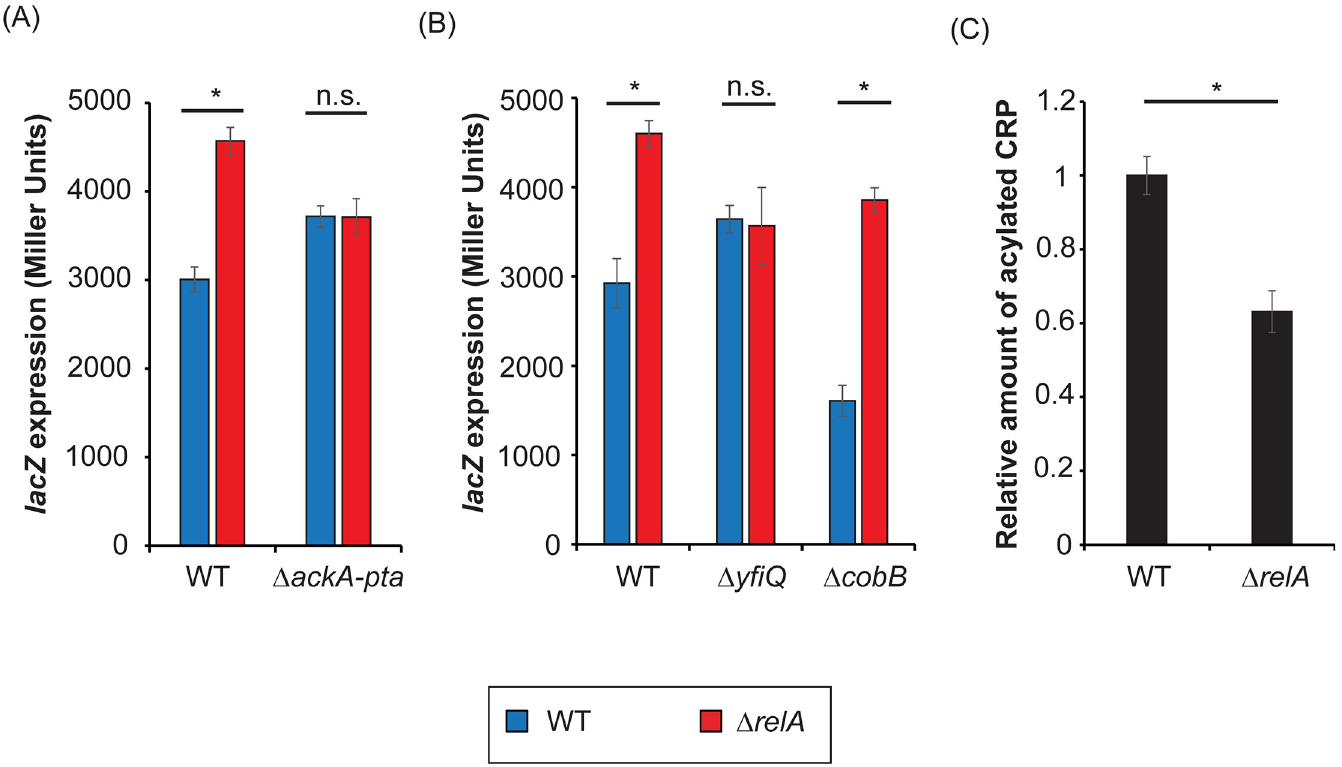
Fig 2. ppGpp affects lacZ expression by promoting CRP acetylation. (A) β -galactosidase activity measure from samples of MG1655 (WT) and CF18005 ( Δ relA ) and their isogenic Δ ackA-pta mutants grown up to exponential phase (OD 600nm 0.1) in M9 minimal media supplemented with glycerol 0.4%. Error bars show standard deviation of 2 biological samples and 3 technical replicates. (B) As before, WT and Δ relA strains, together with their isogenic Δ yfiQ and Δ cobB mutants were grown in M9 minimal media supplemented with glycerol 0.4% up to exponential phase (OD 600nm 0.1) and β -galactosidase activity was measured. Error bars show standard deviation of 2 biological samples and 3 technical replicates. (C) The amount of acetylated CRP, relative to the WT stain, was measured by Western blot from total extracts of WT and Δ relA strains grown in M9 minimal media supplemented with glycerol 0.4% and grown up to exponential phase (OD 600nm 0.1). Western blots and quantification are presented in S6 Fig. Error bars show standard deviation of 2 biological samples. Statistical significance was measured with T-student test ( � p- value < 0.05, n.s. p-value >